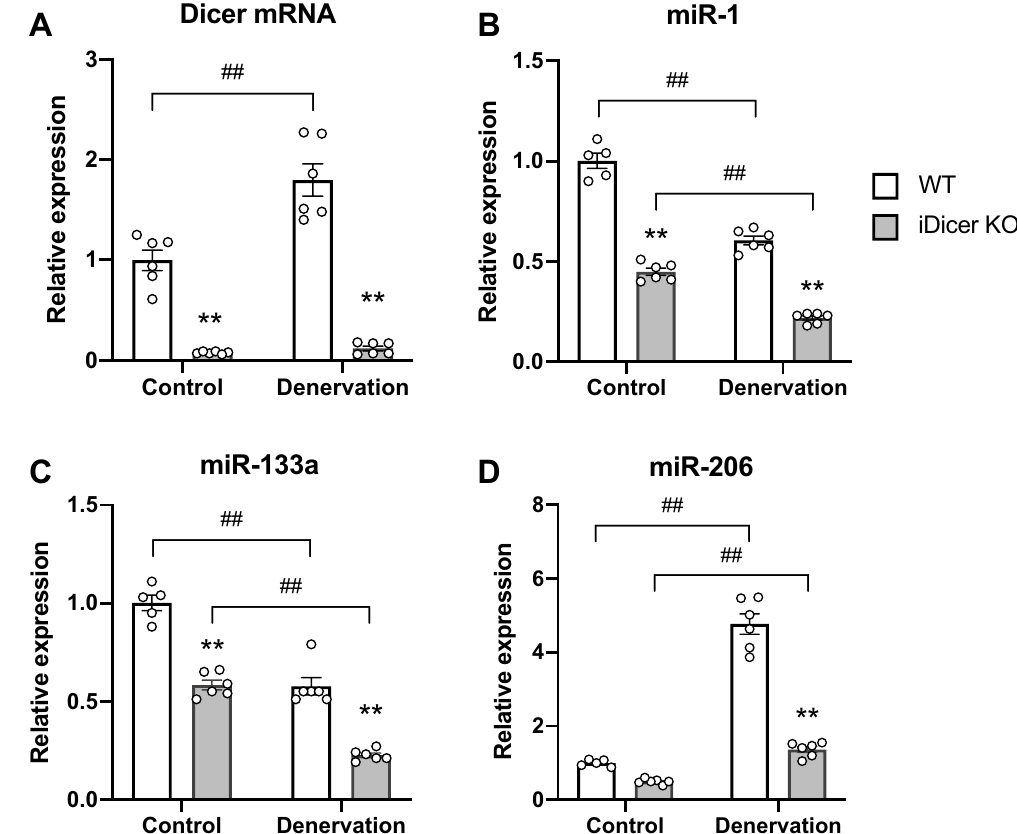
Figure 2. Dicer mRNA and muscle-specific miRNAs levels in plantaris muscles after 2 weeks of denervation. ( A ) A significant reduction in Dicer mRNA levels was observed in both control and denervated-plantaris muscles of iDicer KO mice. Two weeks of denervation increased Dicer mRNA levels in the plantaris muscles from WT mice (n = 6). ( B – D ) Tamoxifen-inducible deletion of Dicer significantly reduced the expression of skeletal muscle-enriched miRNAs, miR-1, miR-133a and miR-206 in both innervated and denervated-plantaris muscles in the iDicer KO mice (n = 5–6). **P < 0.01 vs WT, ## P <